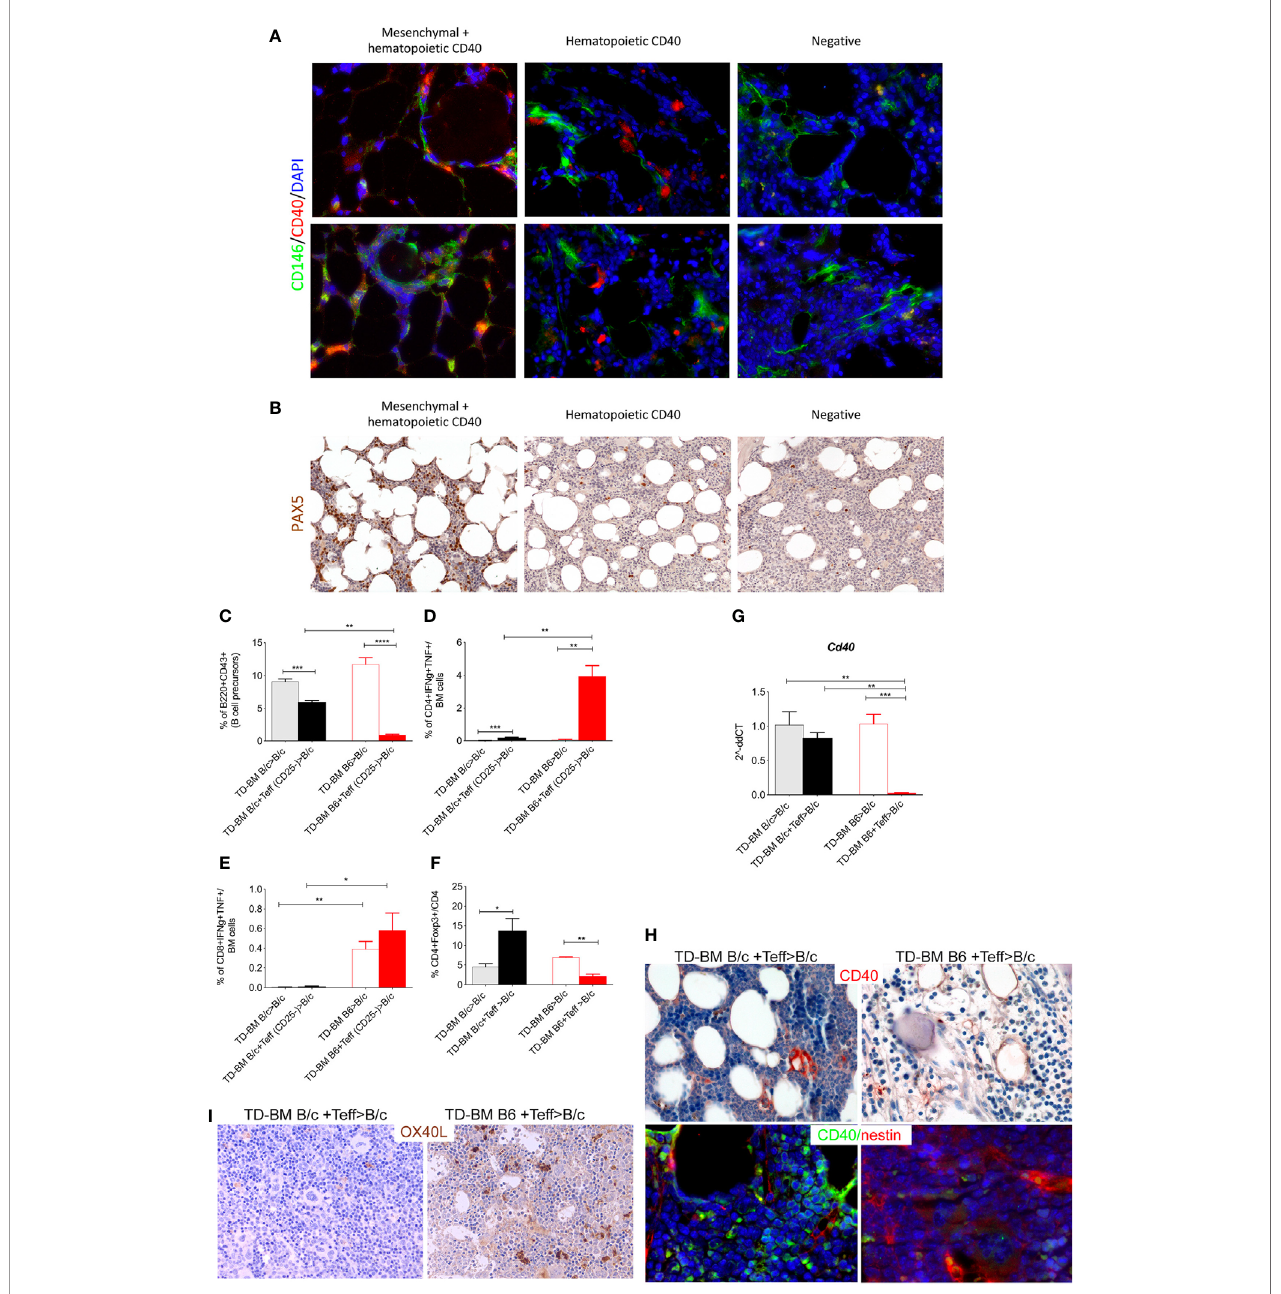
FIGURE 6 | Lack of CD40+ BM-MSCs in BOM from aGVHD patients. (A) Representative double-marker immuno fl uorescence analysis for CD40 (red) and CD146 (green) showing that CD40 expression is shared by CD146+ mesenchymal elements (red arrows) or con fi ned to CD146- hematopoietic cells (white arrows). (B) Pax5 IHC showing a variable expression of Pax5, where the highest fractions of Pax5+ cells were observed in cases in which CD40 was expressed also in the mesenchymal cells. Patient characteristics and quantitative IHC data are included in Supplementary Table 1 . Frequency of B220+CD43+ B-cell precursors (C) , CD4+Foxp3 − Teffs (D) , and CD8+ (E) T-cells releasing IFN g and TNF and the frequency of CD4+Foxp3+ Tregs (F) in aGVHD mice (TD-BM B6+Teff> B/c) compared to those characteristics in control animals. Controls were comprised of mice that did not receive MHC-mismatched Teff (TD-BM B6 > B/c) or MHC-matched BM chimeras (TD-BM B/c+/-Teff> B/c) (*p < 0.05, ***p < 0.001, ****p < 0.0001, one-way ANOVA, Tukey ’ s multiple comparison; n=4/group, one representative experiment out of 3 performed). (G) qPCR analysis of Cd40 expression in BM-MSCs isolated from aGVHD and control mice. **p < 0.005, ***p < 0.001, compared according to ANOVA, Tukey ’ s multiple comparison. (H) Representative CD40 IHC and co-immuno fl uorescence analysis for CD40 (green) and nestin (red) in BM sections from aGVHD (TD-BM B6 + Teff>BALB/c) compared to levels in controls (TD-BM B/c + Teff>B/c). (I) Representative OX40L IHC staining in aGVHD mice (TD-BM B6 + Teff>BALB/c) compared to levels in controls (TD-BM BALB/c +